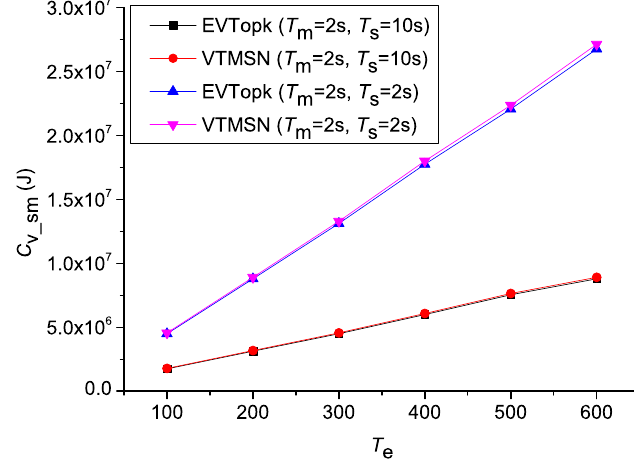
Figure 2. C sm with different settings of T m , T s , and T e